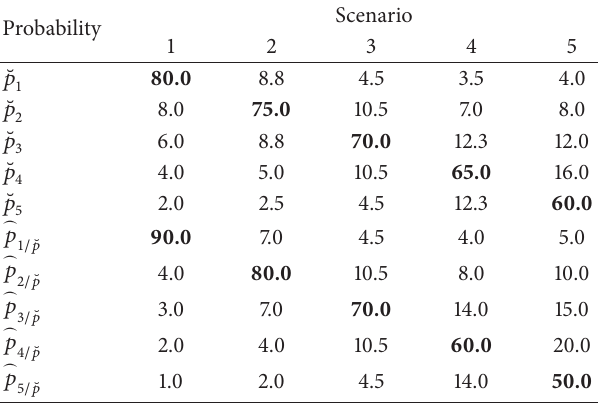
Table 5: Scenarios for different weather forecast information. Probability